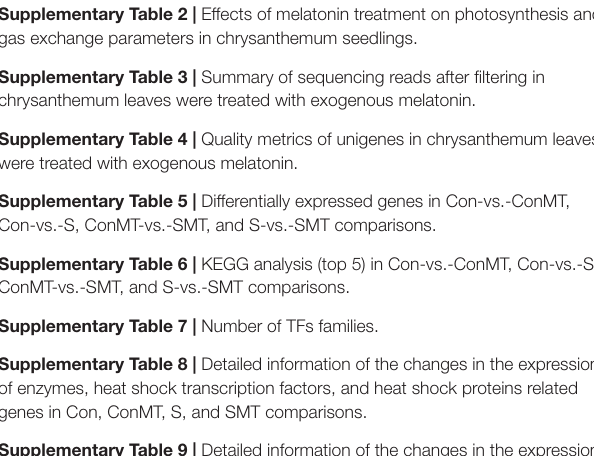
Supplementary Table 1 | Primer sequences of transcriptome qRT-PCR.